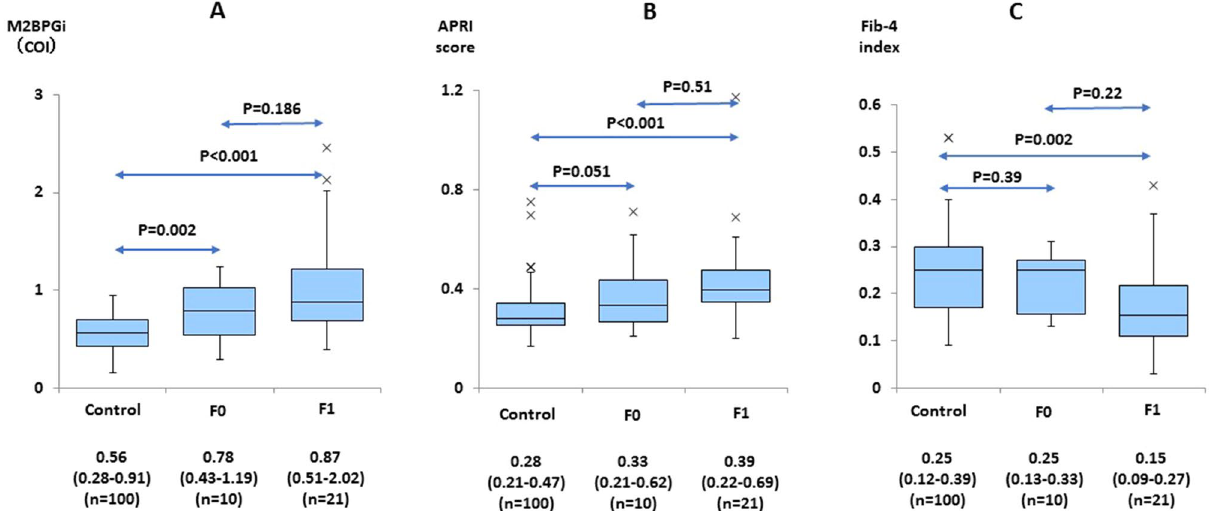
Figure 1. M2BPGi, APRI and FIB-4 levels were expressed by using box-and-whisker plots for control children and for two groups of patients with chronic hepatitis C (F0 and F1). Median value with 95% confidence interval were described for the control, F0 and F1 groups.